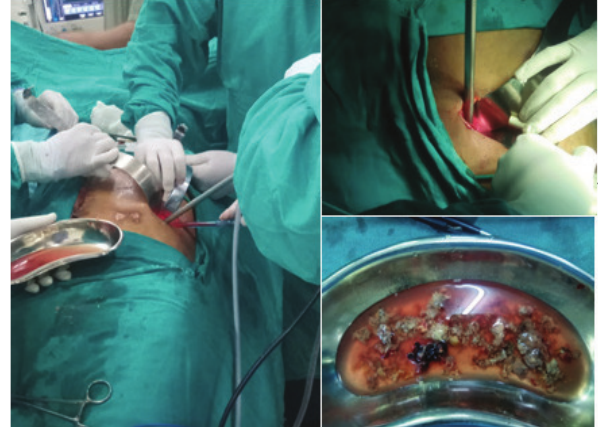
Figure 5: Photo showing Video-Assisted Retroperitoneal Drainage, following CT guided pigtail drainage and lavage